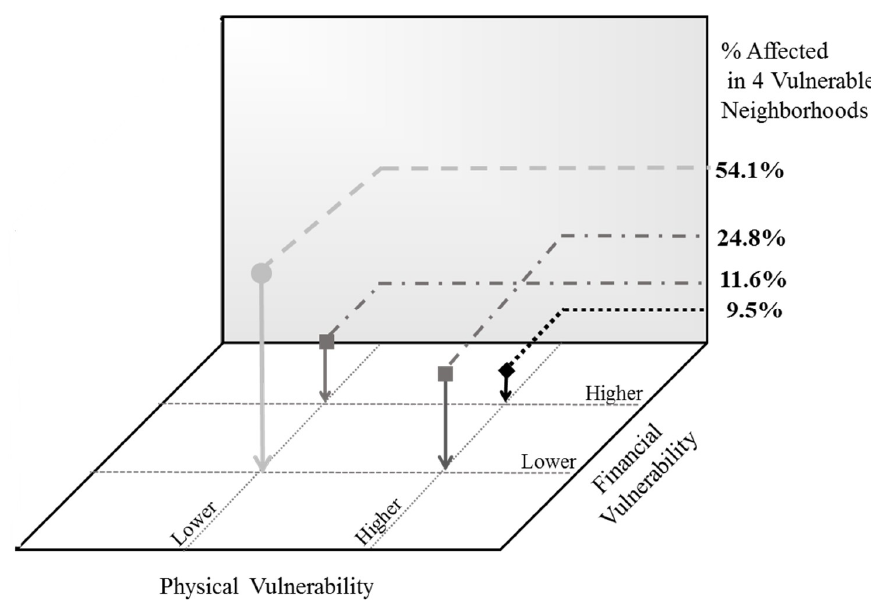
Figure 5. Composite vulnerability (population weighted data).